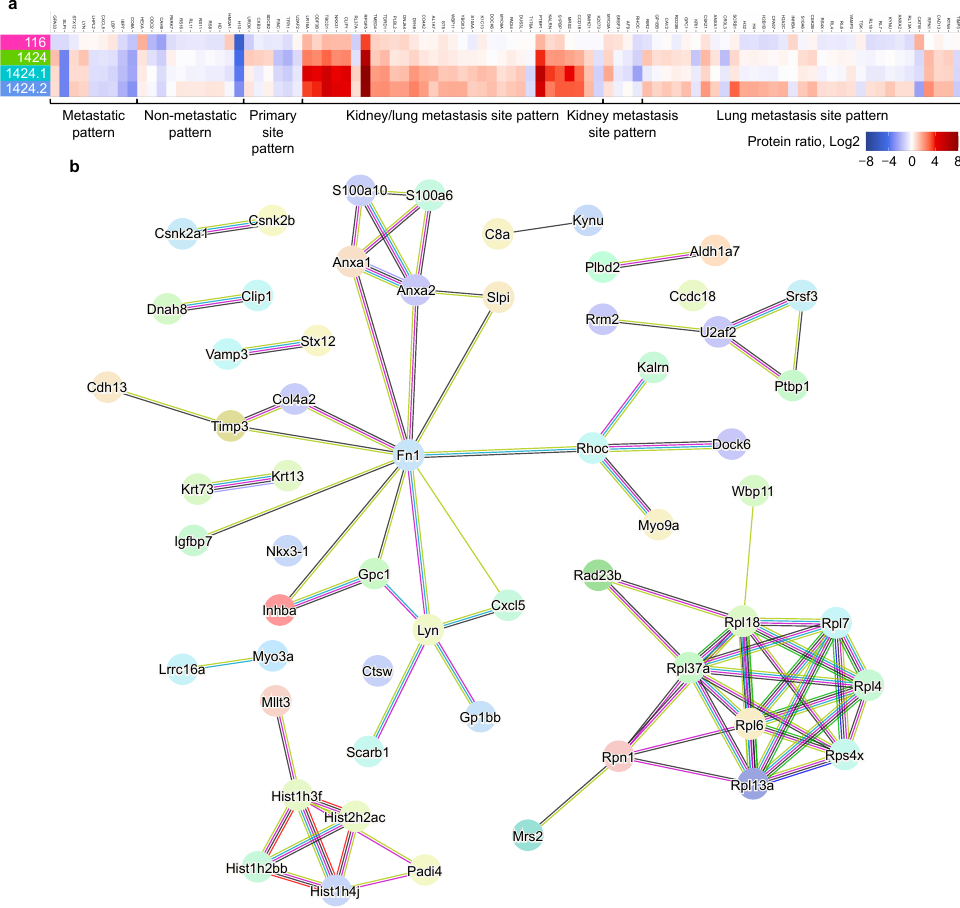
Figure 4. Determination of metastatic-specific altered proteins. ( a ) Classification of metastasis- specific altered proteins by their abundance profiles in the metastatic and non-metastatic BC cell lines. ( b ) Protein–protein interaction (PPI) network of the 83 metastasis-specific proteins, generated by